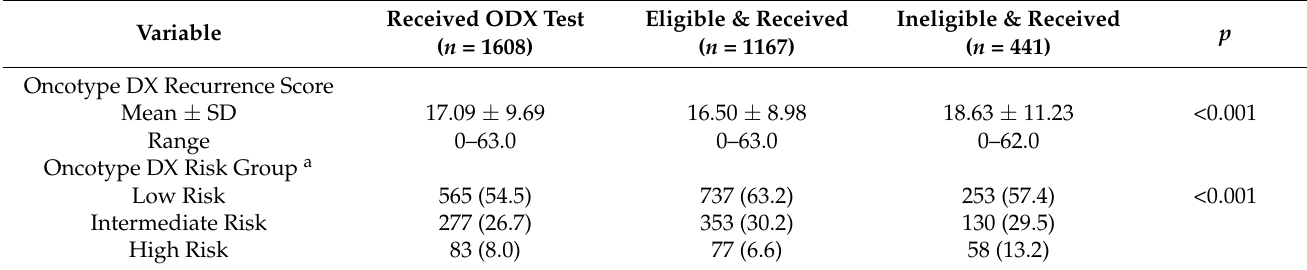
Table 2. Oncotype DX recurrence risk score and risk group among Latina/Hispanic breast cancer cases who received the test ( n = 1608), New Jersey,